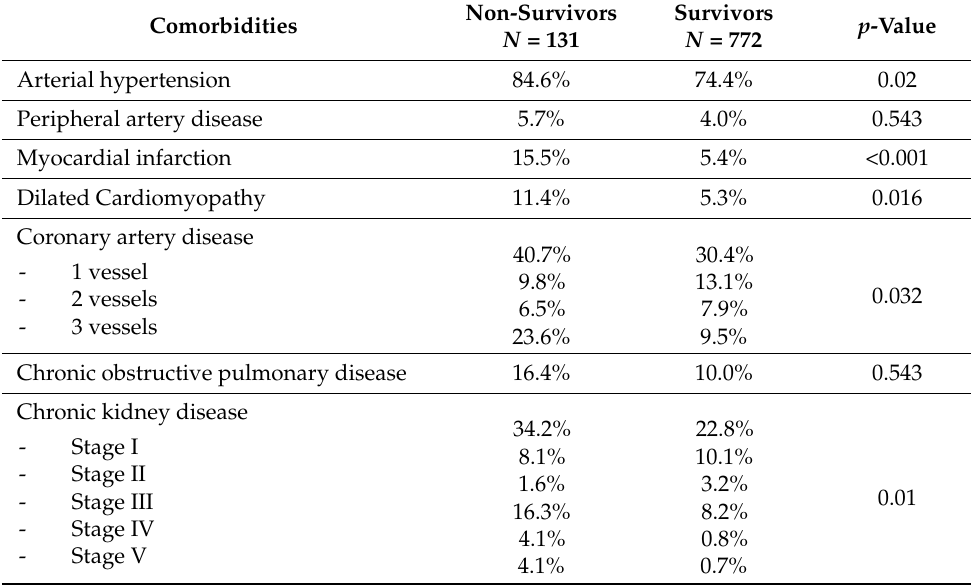
Table 3. Influence of comorbidities on mortality.